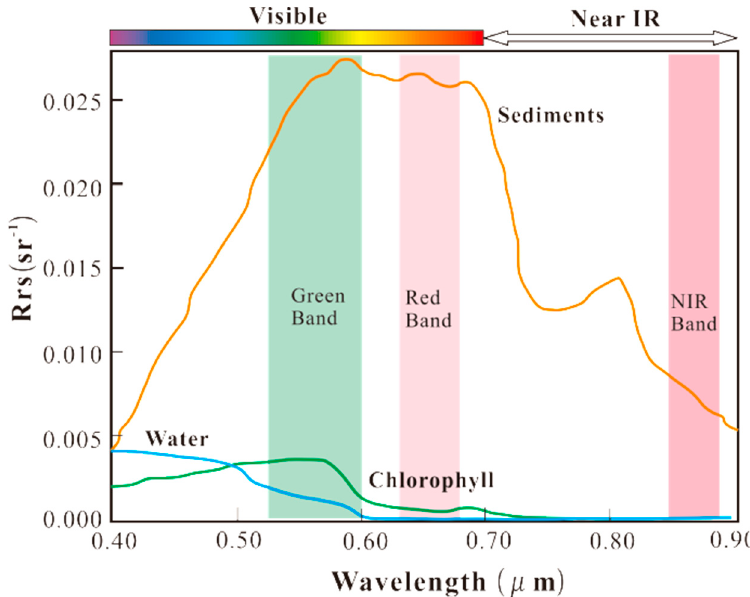
Figure 5. Remote sensing reflectance (Rrs) of clear water (blue), water with chlorophyll content (green), and water with sediments (orange). The green, red, and NIR bands of Landsat 8 images are drawn in the above figure. Note that the figure is modified from Sherry’s research [44].